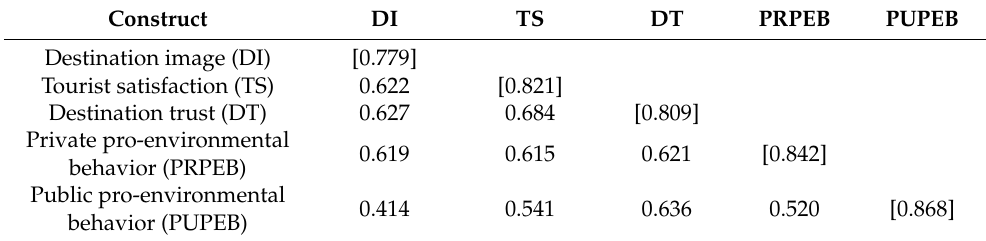
Table 3. Discriminant validity assessment.